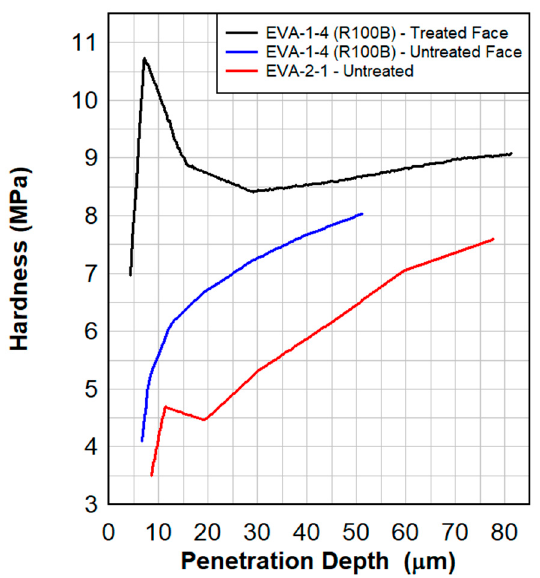
Figure 12. Hardness as a function of the penetration depth for the radiated and virgin EVA specimens. The treated material shows significant hardening in the first 10 µ m of the surface, which could resist the cutting of polymer by glass shards during a blast.